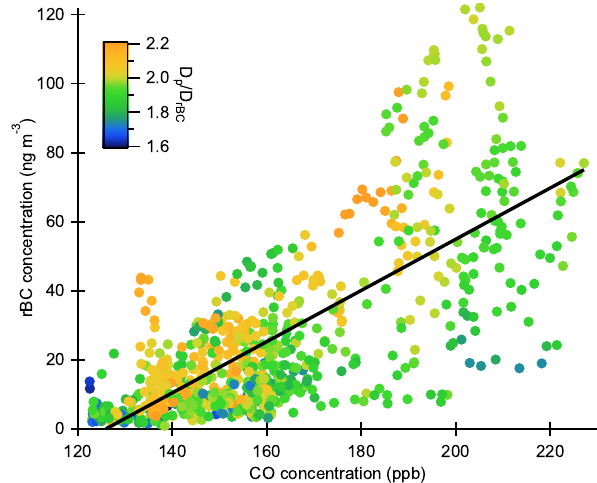
Figure 4. SP2 rBC mass concentration as a function of carbon monoxide (CO) concentration. Marker color shows the particle to rBC core diameter ratio for each data point. The solid black line shows the linear fit to the